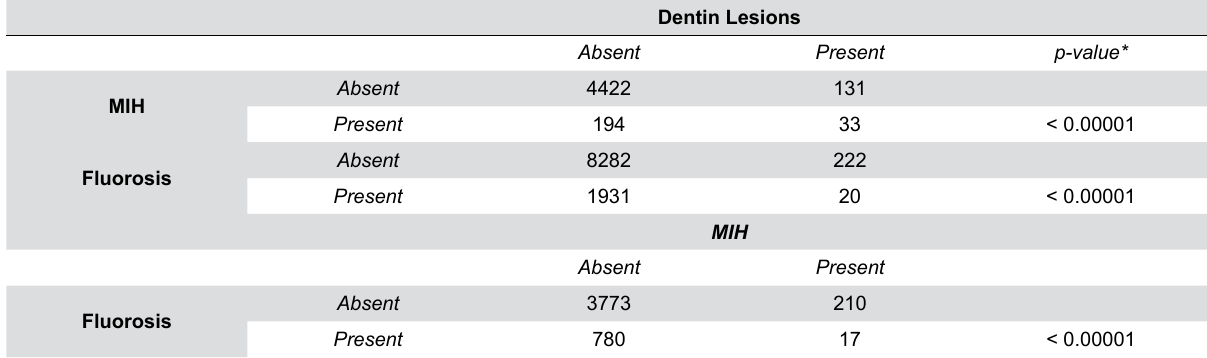
Table 5- Frequency and statistical analysis of the three dental conditions (DC, DF, MIH) at the tooth